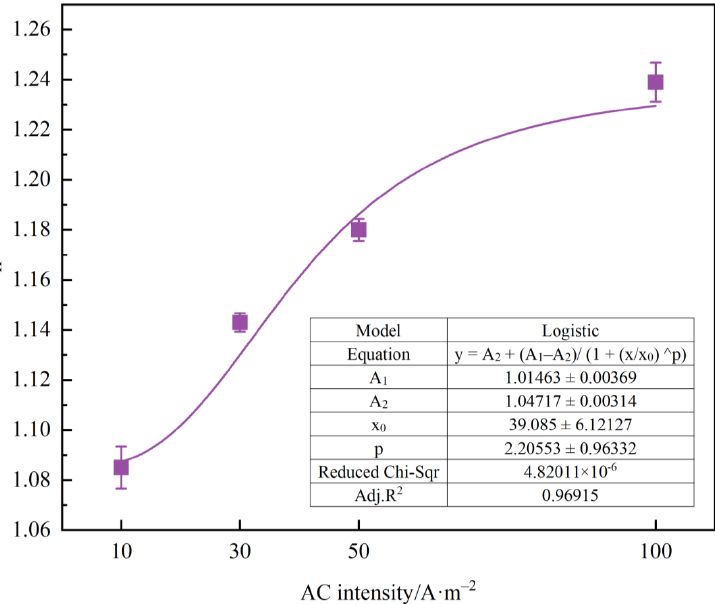
Figure 13. The curves for n varied with different AC intensities. n represents the ratio of the anodic dissolution rate of the galvanic couple electrodes with and without AC interference calculated by the AC corrosion model. Table 5. Results based on the analysis of variance. Three Types of Source Sums of